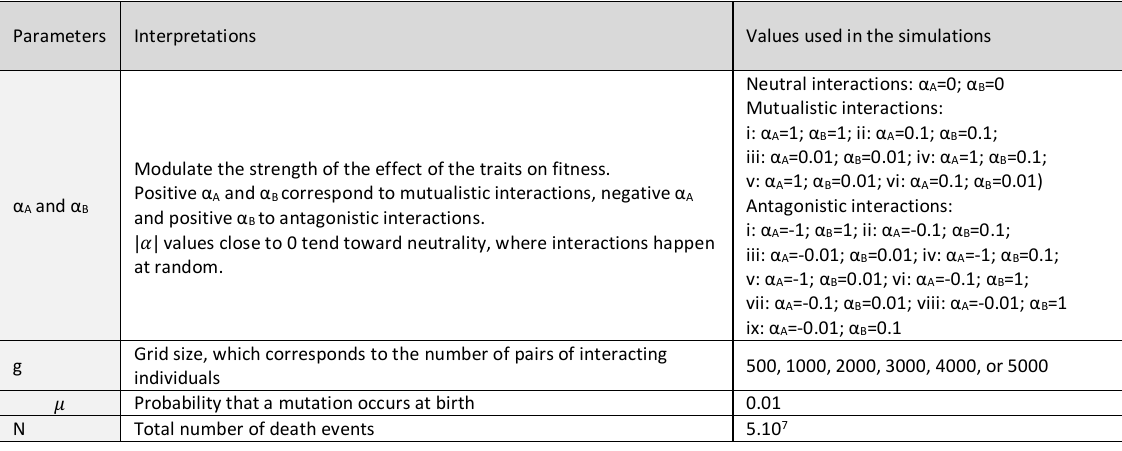
Table 1: Parameters used in the simulations: (a) Parameters used for simulating interaction networks with or without phylogenetic signal in species interactions using